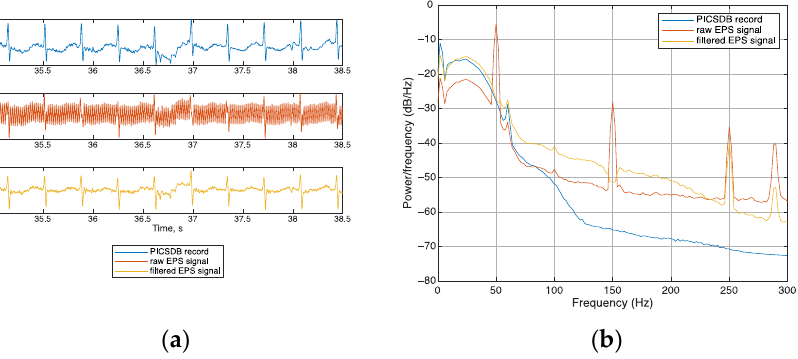
Figure 5. A sample illustrating filtering of the PICSDB data record ecg8, showing ( a ) sample wave- forms and ( b ) power spectral density. forms and ( b ) power spectral